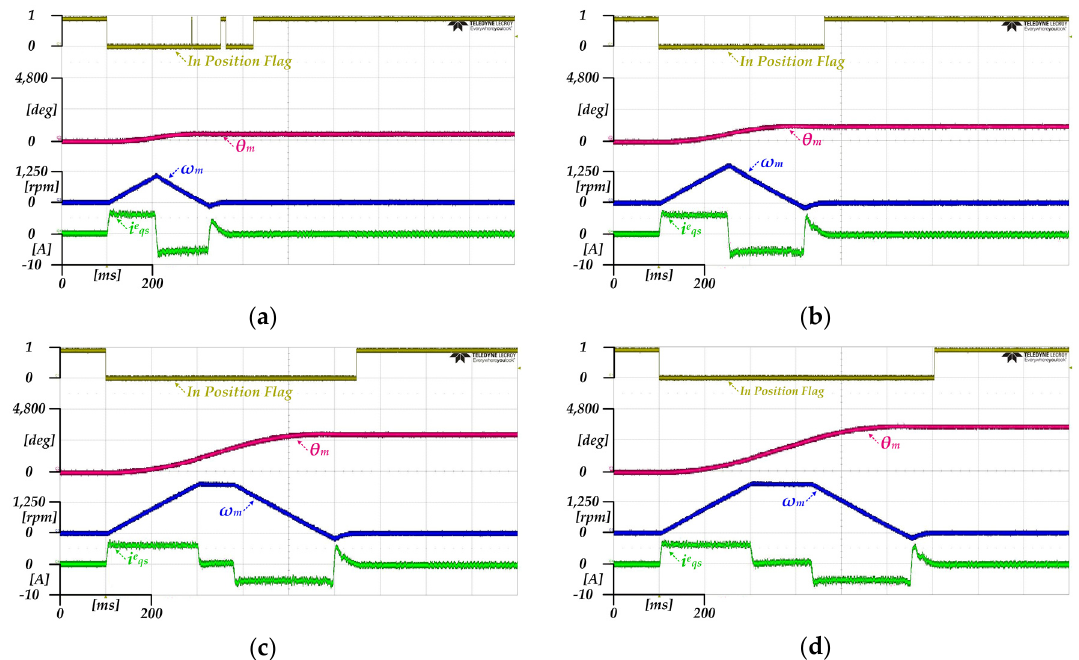
Figure 12. Position, velocity and q-axis current of the proposed method under the underdamping condition ( a ) 600 [deg] position reference; ( b ) 1200 [deg] position reference; ( c ) 3000 [deg] position reference; ( d ) 3600 [deg] position reference.